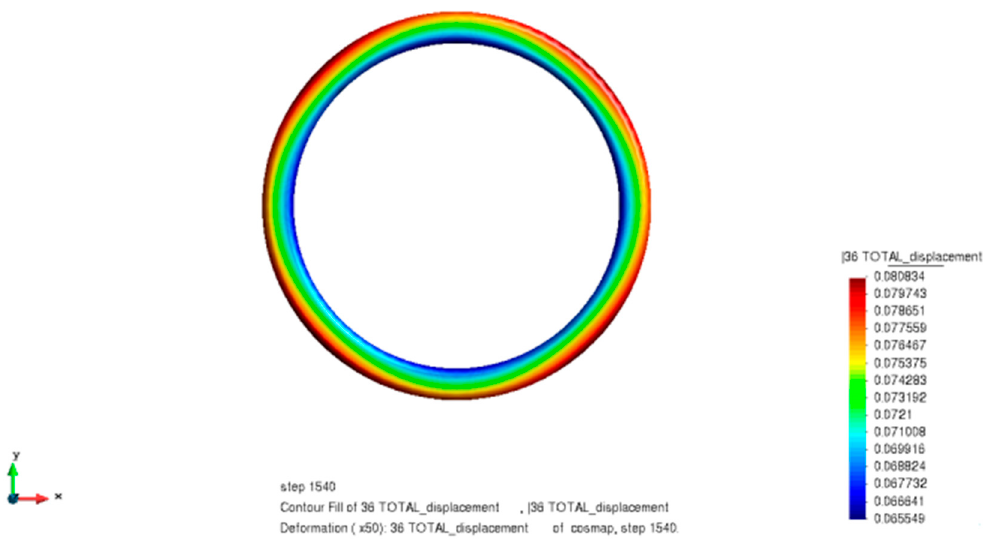
Figure 11. Deformation (×50) by axial symmetry heat